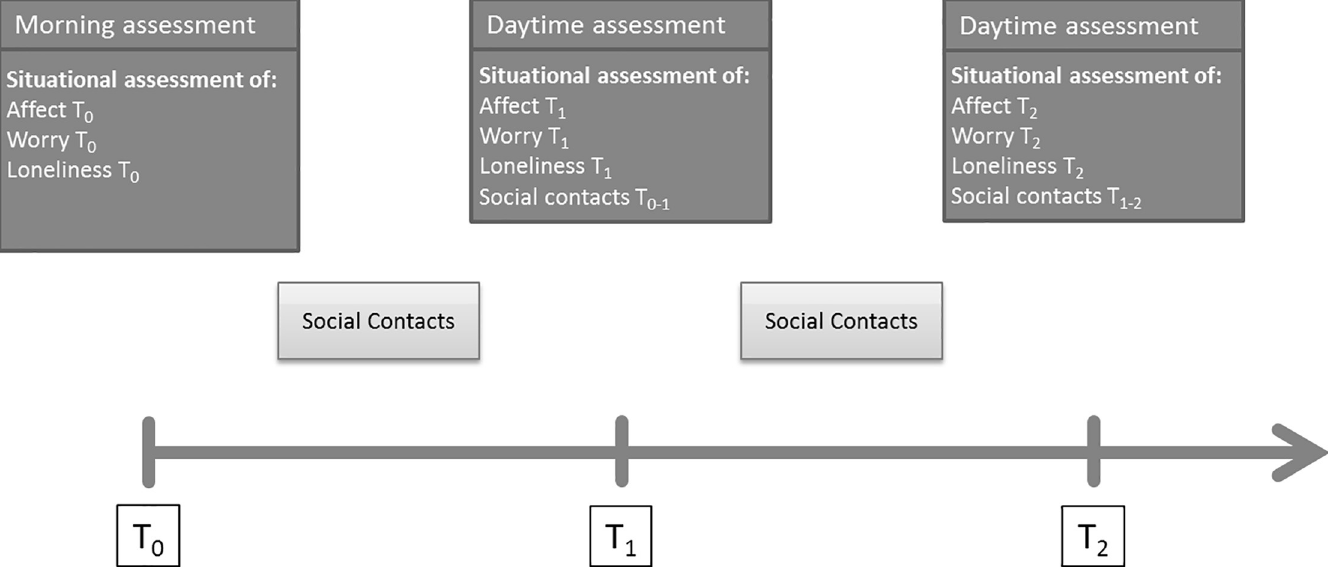
Fig 1. Concept scheme of the employed assessment protocol, exemplifying the prediction of social contacts at T 1-2 , as assessed at T 2 , from information obtained at T 1